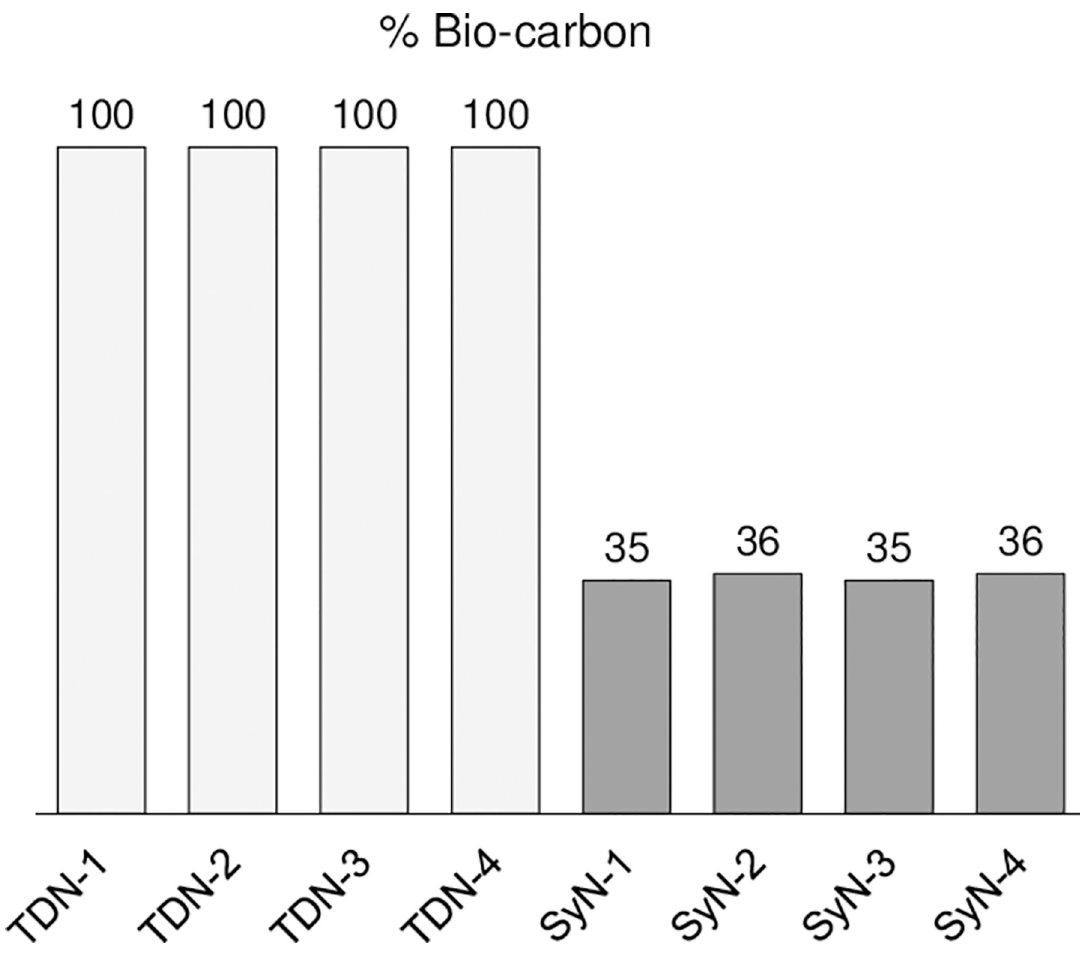
Fig 6. Radiocarbon analysis of neat tobacco-derived and synthetic nicotine